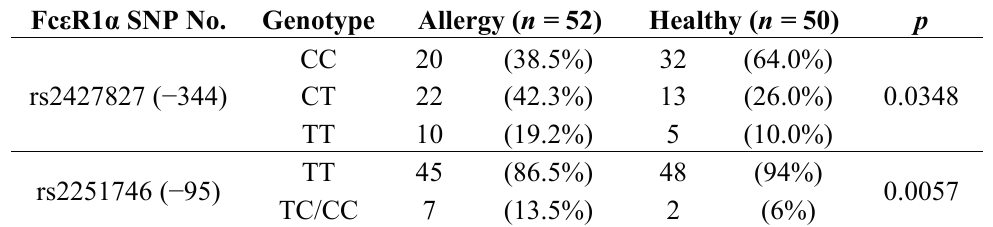
Table 2. Genotype difference of Fc ε R1 α promoter region between allergic and normal subjects. Fc ε R1 α SNP No.